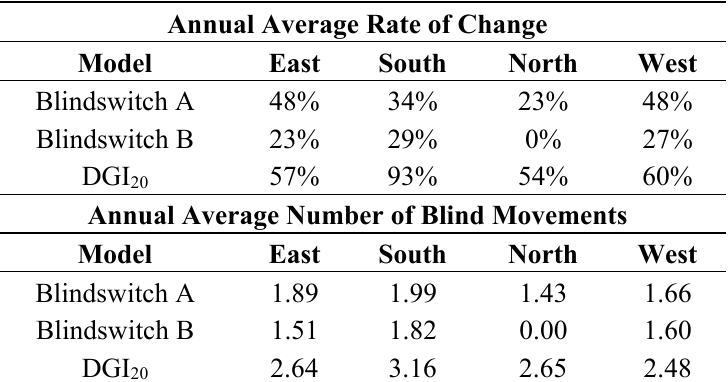
Table 5. Annual average ROC and NBM